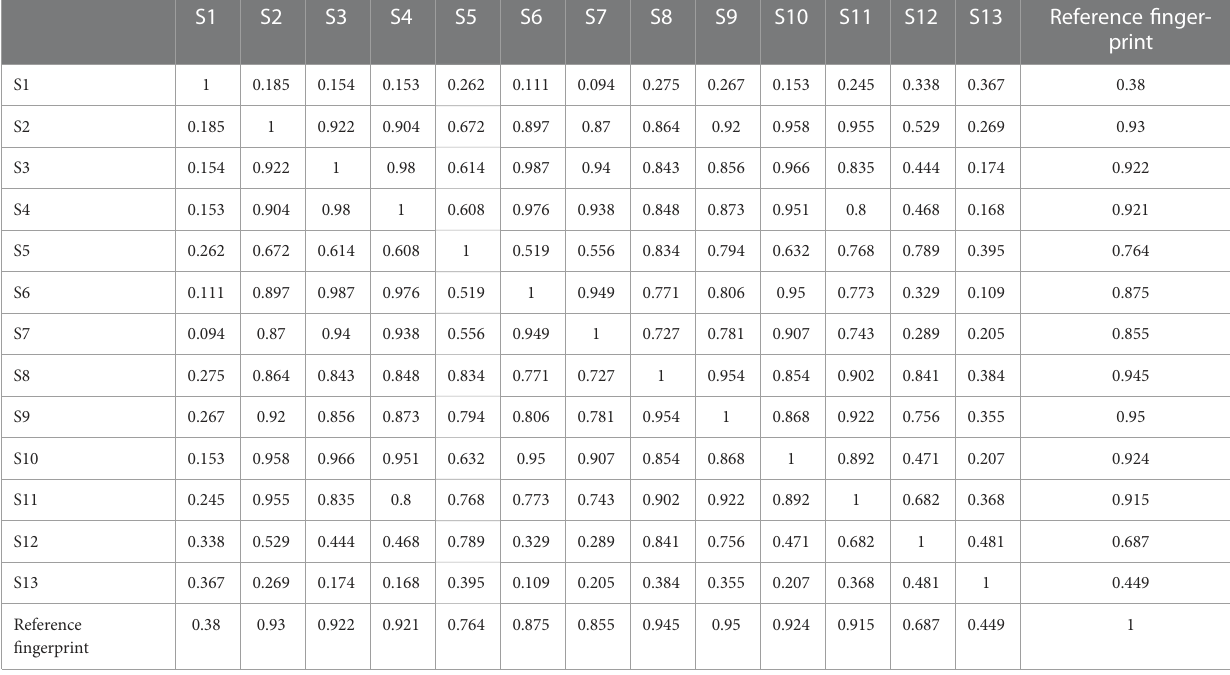
TABLE 2 Similarity of mulberry branches from different planting